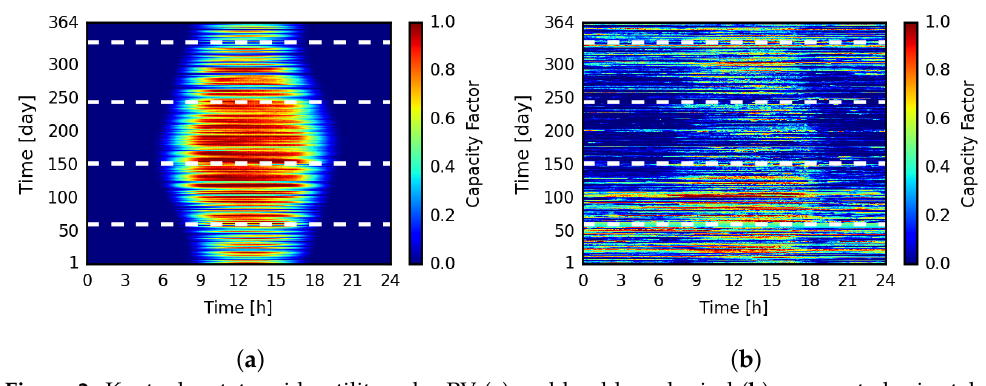
Figure 2. Kentucky state-wide utility solar PV ( a ) and land-based wind ( b ) aggregated minutely generation capacity factor across the year with white dotted lines differentiating meteorological seasons. Resources were found to be beneficially disjoint and complementary with high output from solar PV in the summer months and wind in the winter